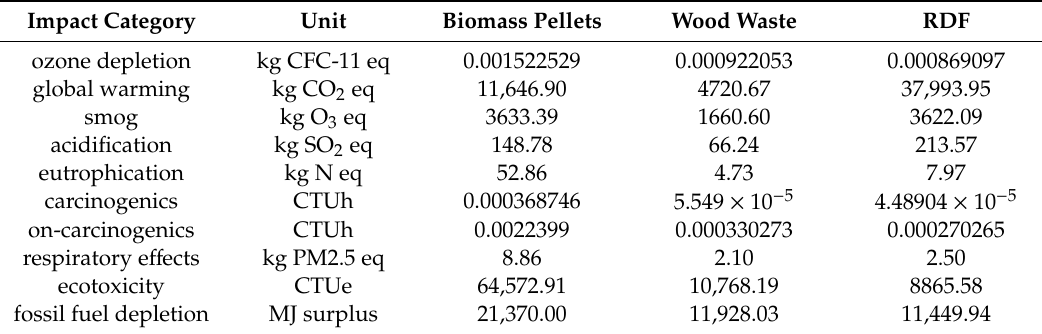
Table 9. Results of life cycle impact analysis for the heating system fed with proposed fuels.